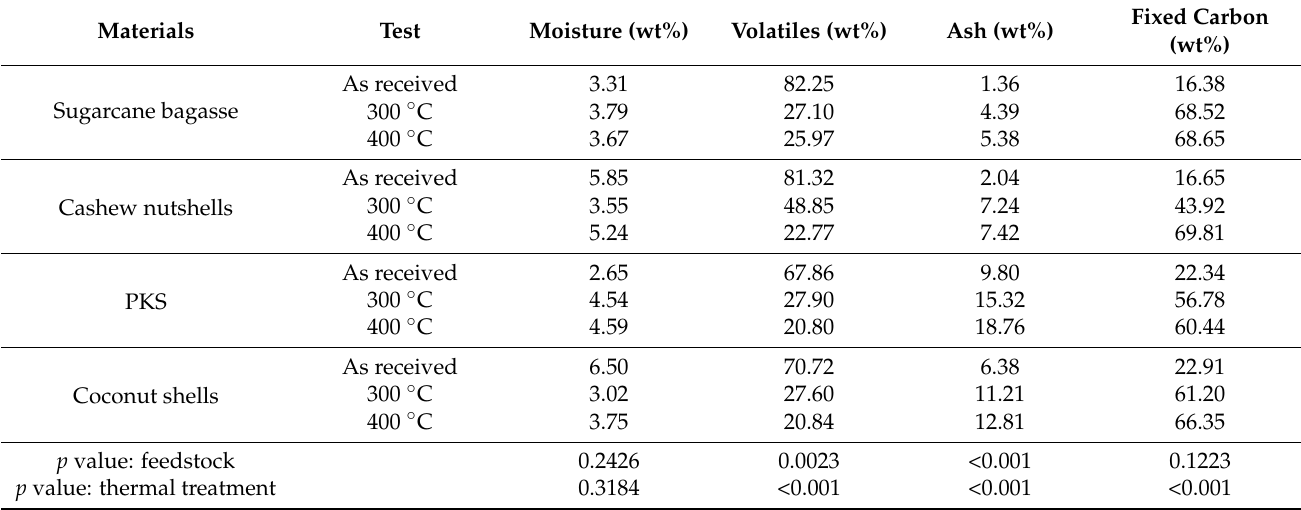
Table 3. Results obtained in the proximate analysis (average values shown).